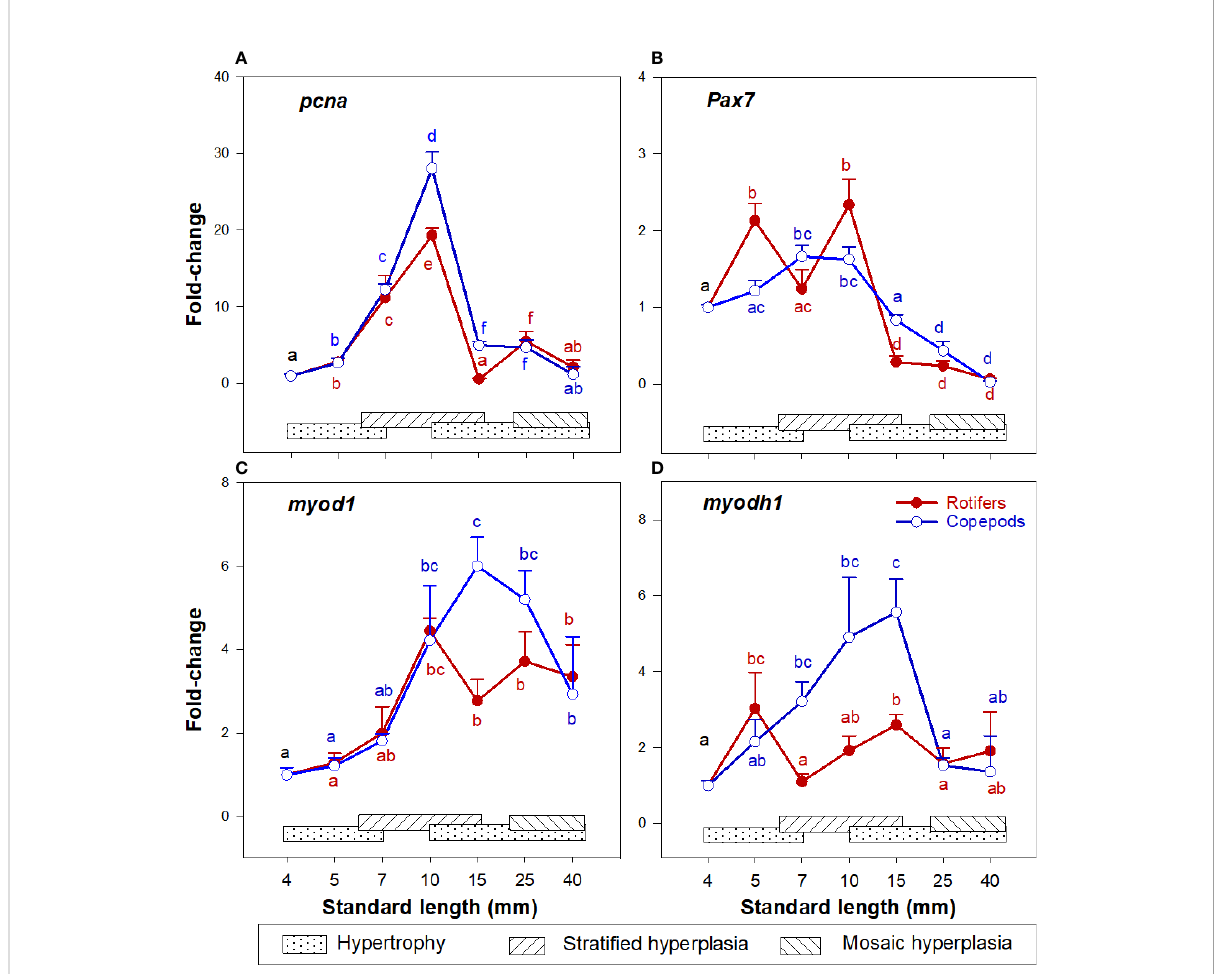
FIGURE 5 Gene expression (qPCR) of (A) pcna; (B) pax7; (C) myod1; and (D) myodh1 in skeletal muscle tissue of Atlantic cod larvae fed rotifers/Artemia (red line) or Copepods (blue line) (quantitative real-time PCR (qPCR) in relation to muscle growth dynamics: Muscle growth